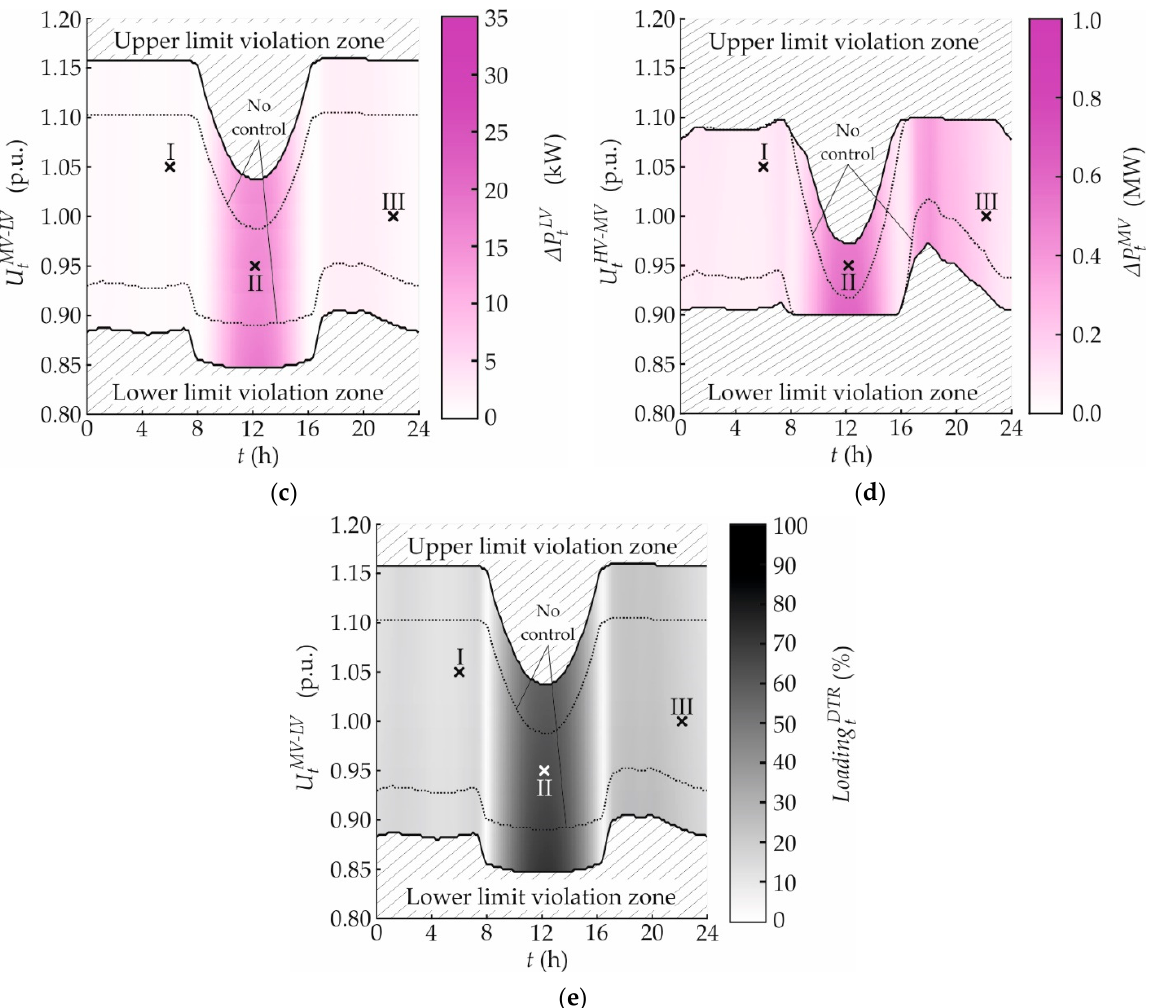
Figure 19. Daily behavior of the test link chain for various boundary voltages and the OLTC local control: ( a ) reactive power exchange over the MV − LV boundary (rural LV_Link-Grid); ( b ) reactive power exchange over the HV − MV boundary; ( c ) active power loss within the rural LV_Link-Grid; ( d ) active power loss within the MV_Link-Grid; ( e ) DTR loading (rural LV_Link-Grid).